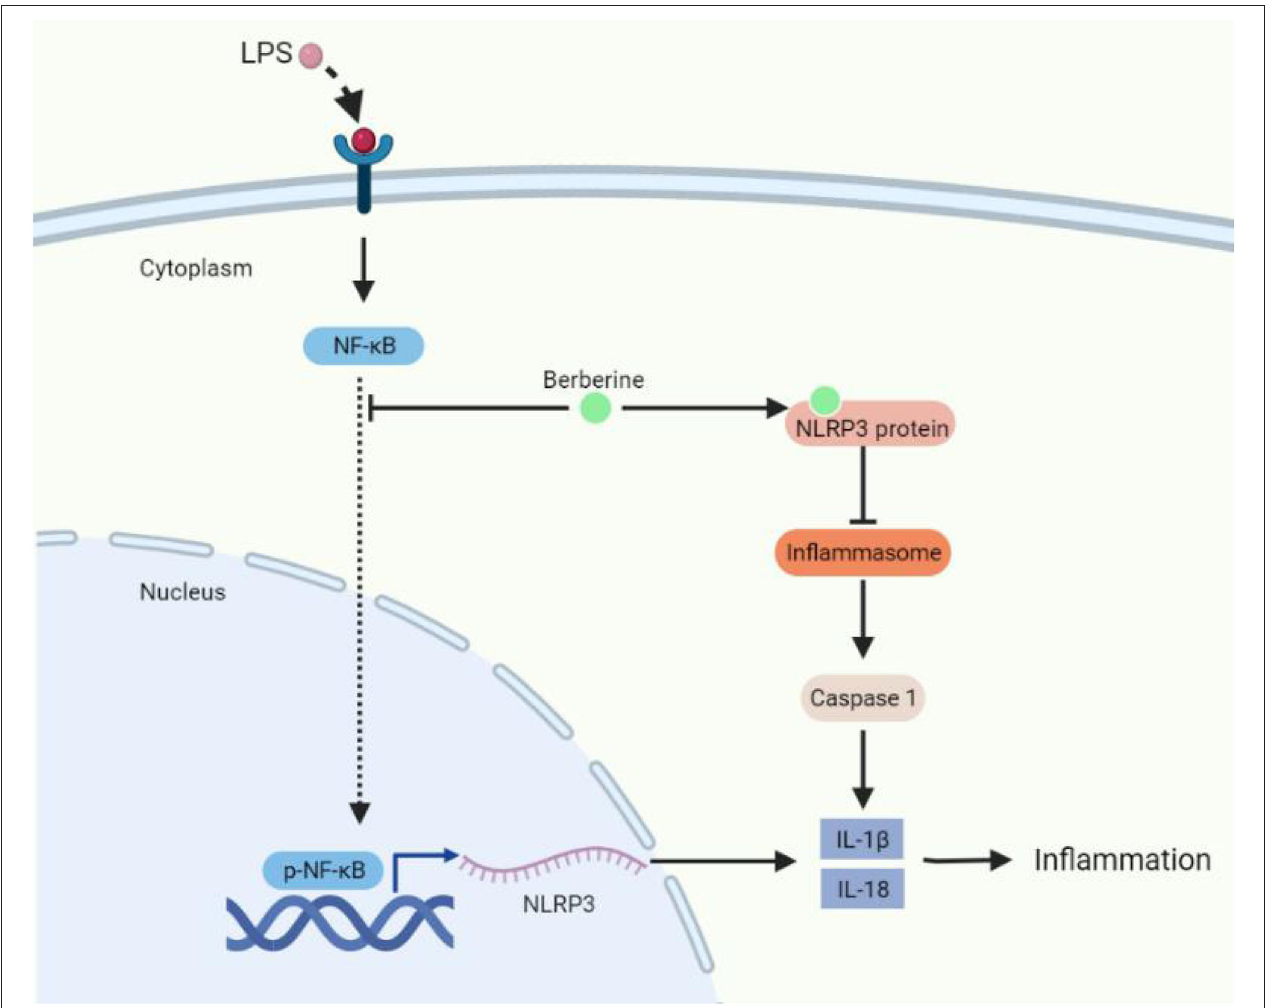
FIGURE 8 | The molecular mechanism of berberine protecting lung injury under inflammatory